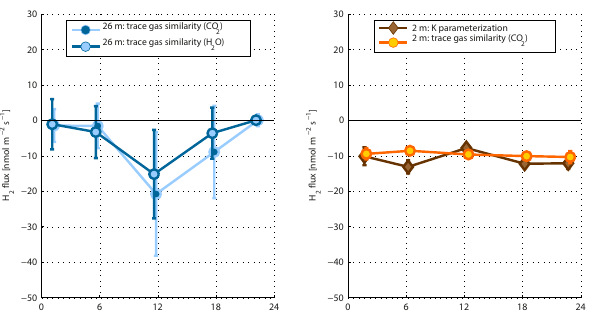
Figure 10. Comparison of summertime H 2 fluxes (15–22 July 2011 period) above (left) and below (right) the canopy: trace gas similar- ity via CO 2 or H 2 O, eddy covariance (eddy), K parameterization, and trace gas similarity via flux chamber data. Data points represent 6h aggregate mean and 95% confidence